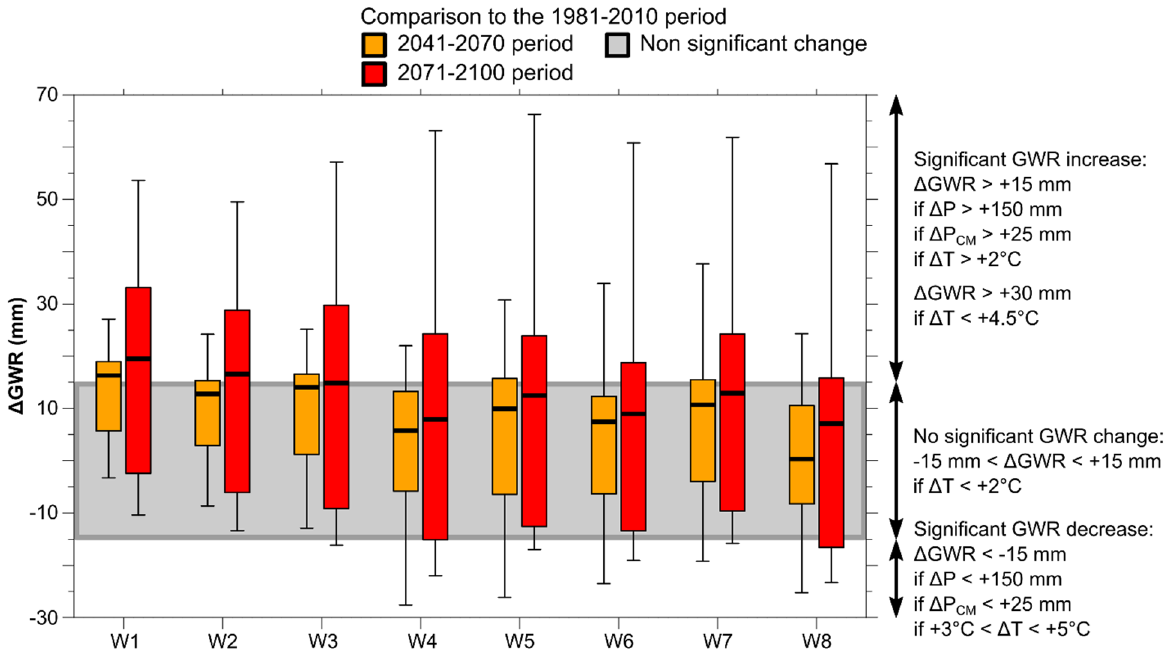
Figure 9. Annual groundwater recharge changes ( Δ GWR) between the reference period (1981 − 2010) and future periods (2041 − 2070 and 2071 − 2100) for the eight watersheds (W1 − W8) and 12 scenarios. The associated precipitation and temperature thresholds are displayed on the right, and the gray zone indicates the − 15 to +15 mm non-significant change range in GWR. CM stands for cold months (December to March).